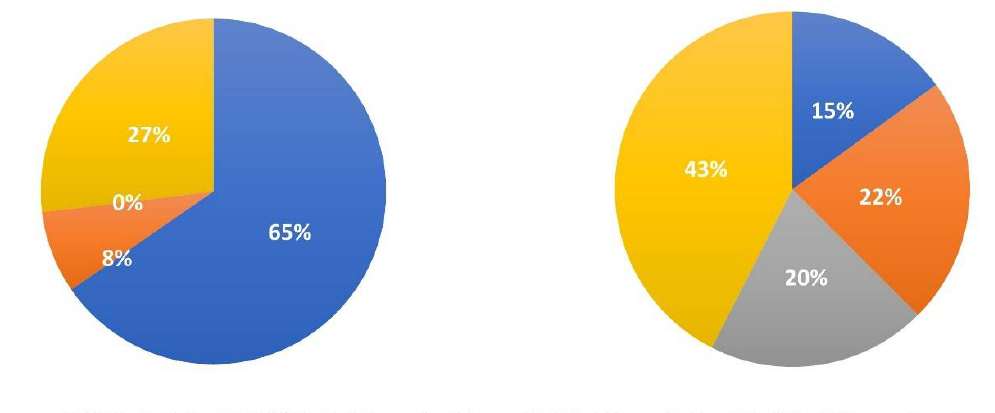
Figure A6. Distribution of vulnerability levels referring to the freeboard for bridges in the main ( left ) and the secondary ( right ) hydrograph networks, RT = 200.